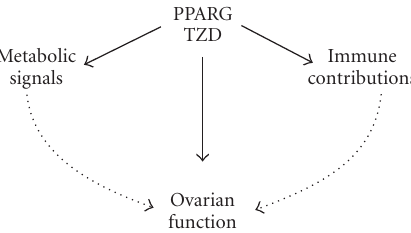
Figure 3: Schematic summarising the developing concept of PPARG influence on ovarian function and female fertility. PPARG is able to strongly influence the activity of ovarian cells directly, in par- ticular steroidogenesis and tissue remodelling. In addition, PPARG can further influence ovarian function via regulation of external metabolic signals and immune cell